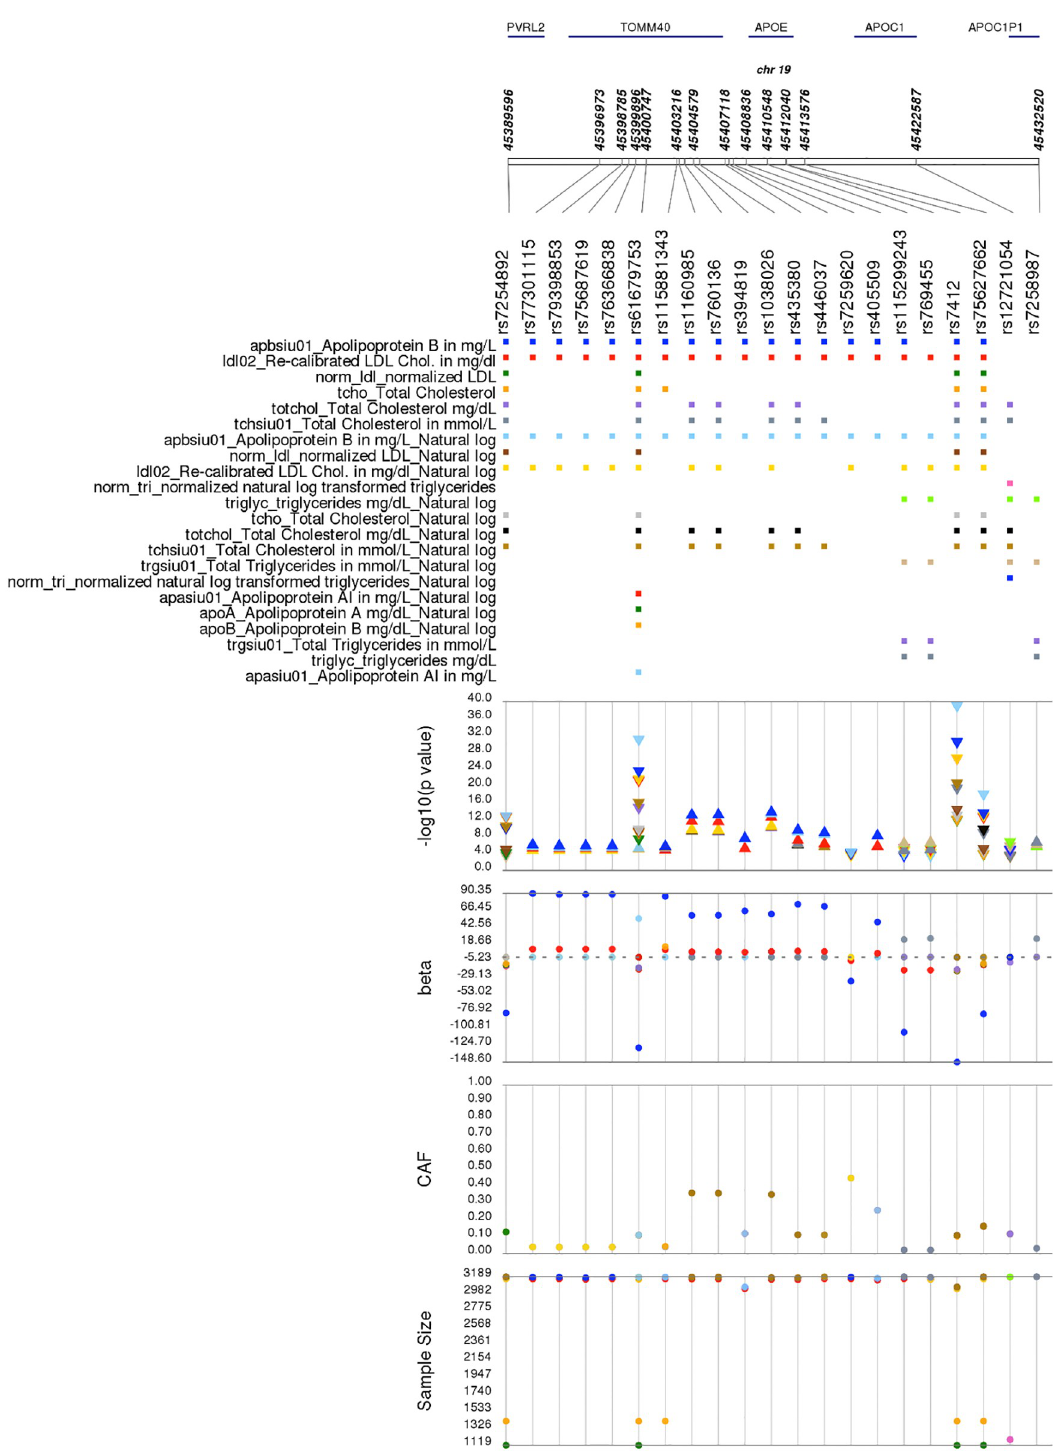
Fig 3. APOE rs7412 and nearby single nucleotide polymorphisms associated with lipid-related traits in a single Population Architecture using Genomics and Epidemiology (PAGE) study. Plotted are single SNP tests of association in the Atherosclerosis Risk in Communities (ARIC) for APOE rs7412 and nearby SNPs within 100kb of previously-reported genome-wide association study (GWAS) associations also associated here at p < 1.0x10 -4 with lipid-related traits. Data shown are sample size, coded allele frequency (CAF), genetic effect size (beta), -log10(p-value), and ARIC phenotypes on the y-axes. Each SNP is plotted on the x-axis at